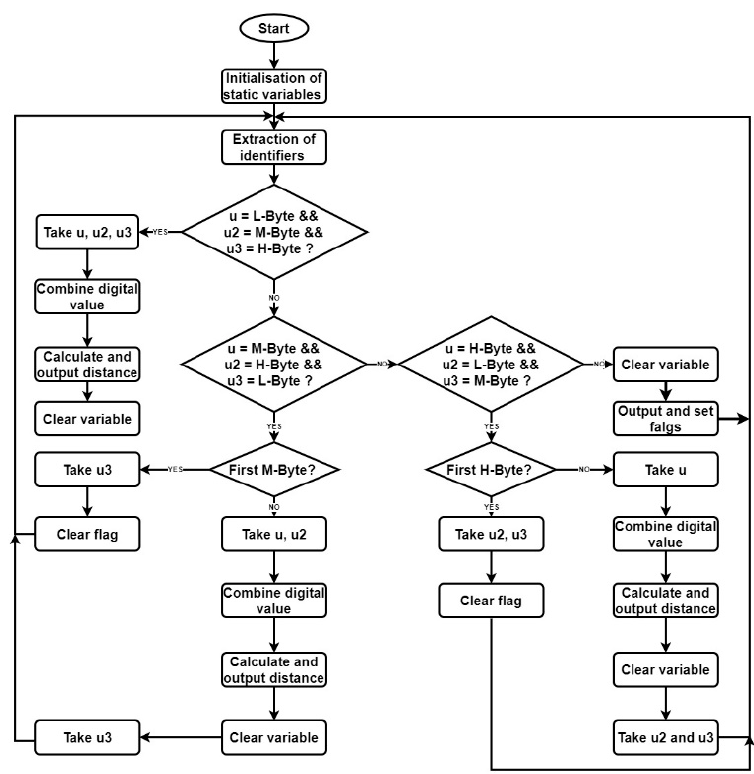
Figure 5. Flow chart function Absolute RS-422.